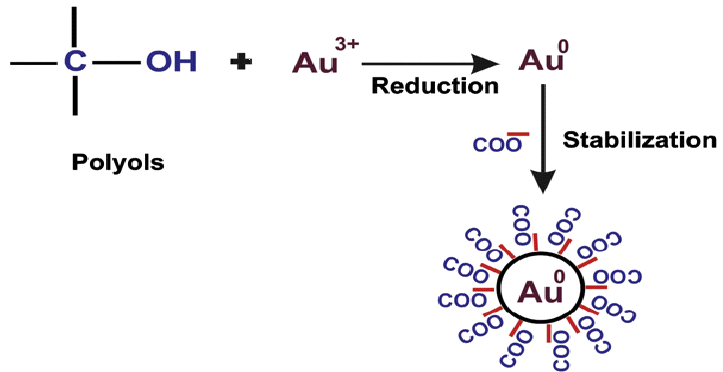
Fig. 4. Mechanism of formation of gold nanoparticles.